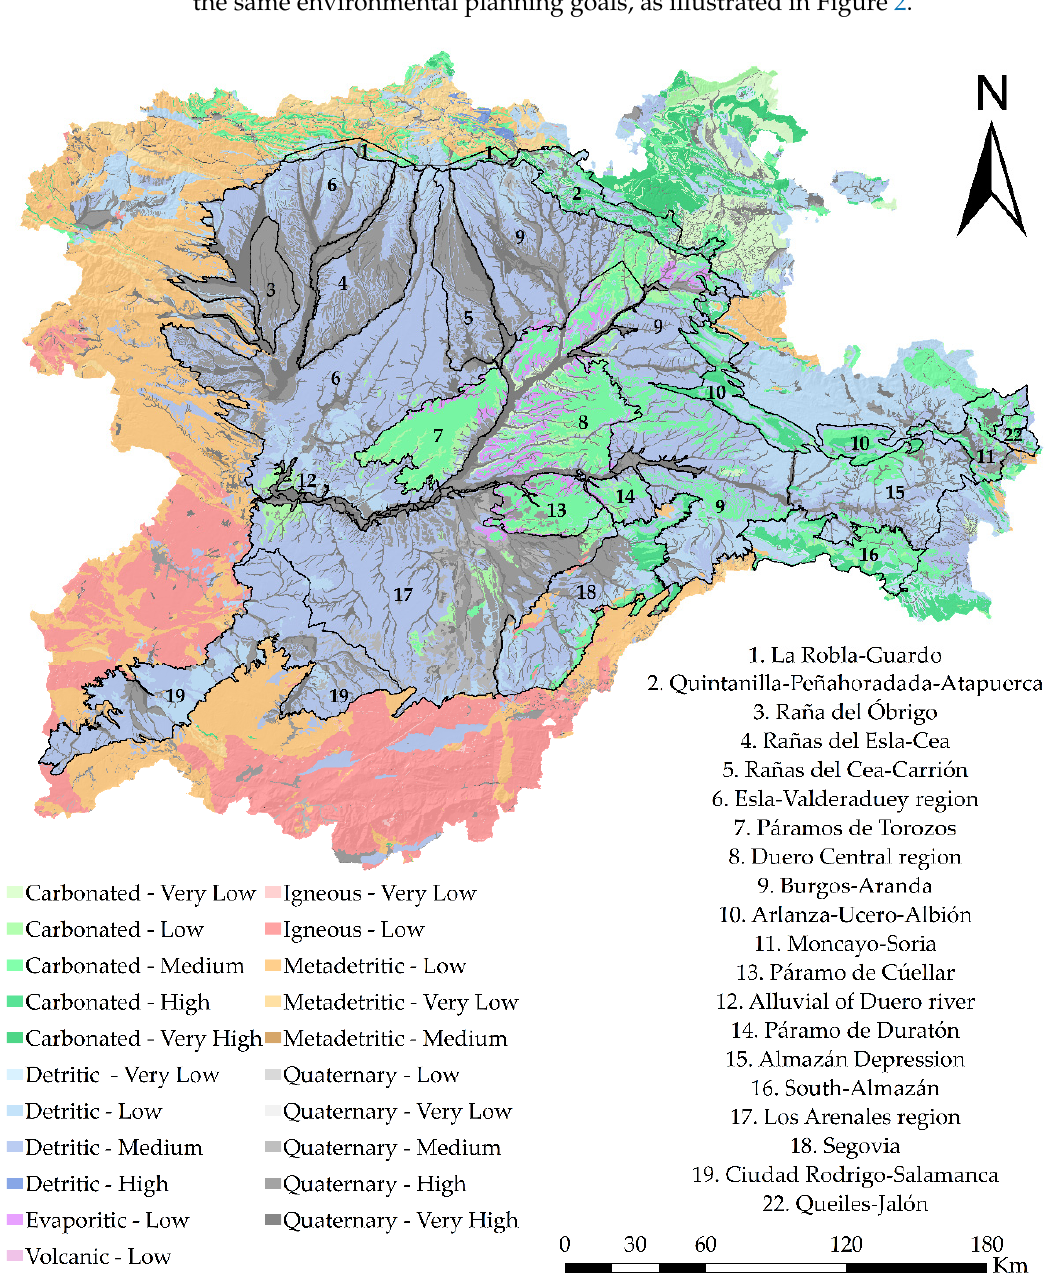
Figure 2. Permeability map of the Castilla y León region according to the main lithologies. Black lines limit the 20 hydrogeological units of the DHC studied.